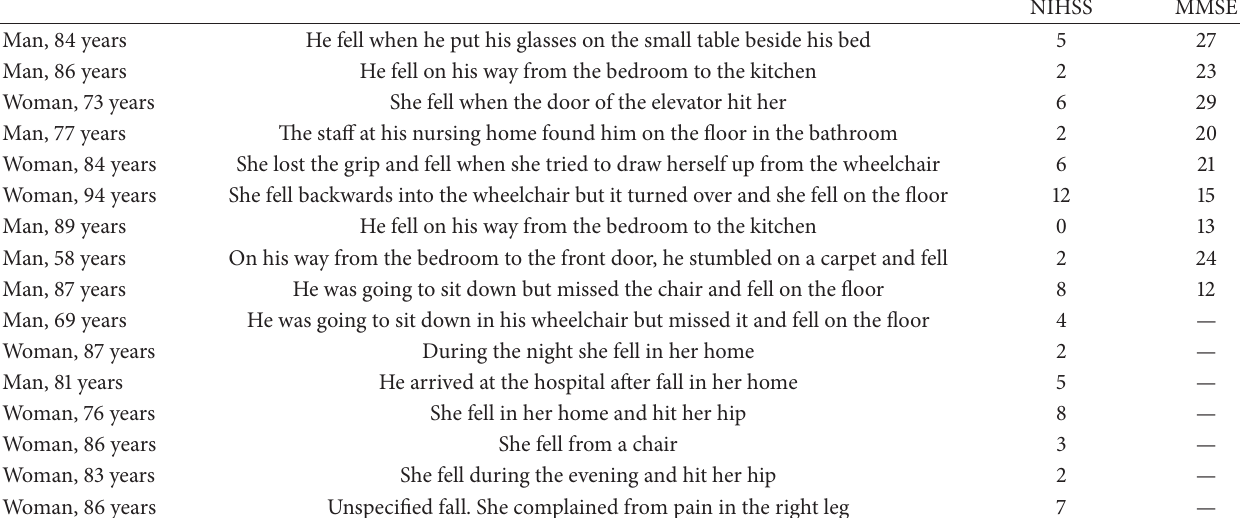
Table 2: The circumstances that prevailed when the persons sustained the hip